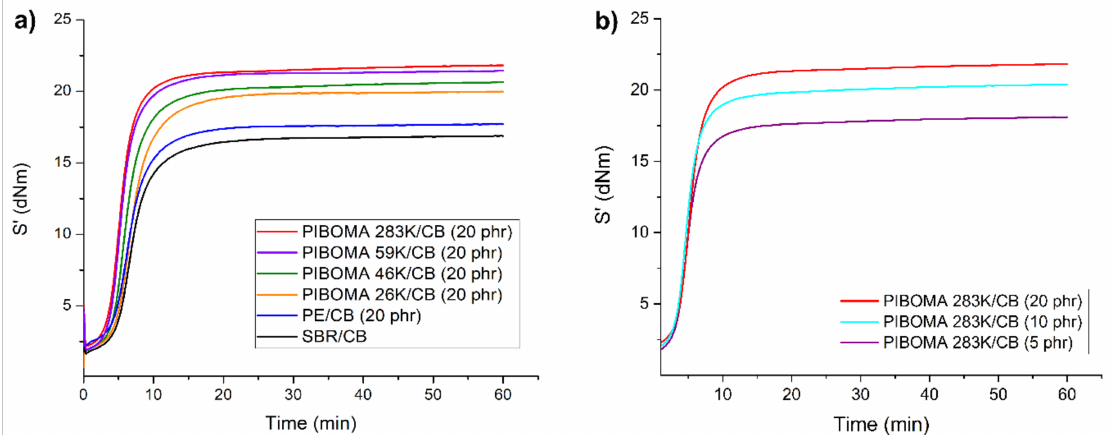
Figure 3. Rheographs of rubber compounds filled with 50 phr of CB and 20 phr of PIBOMA with variable molecular weights ( a ) and of those containing different amounts of PIBOMA 283 K ( b